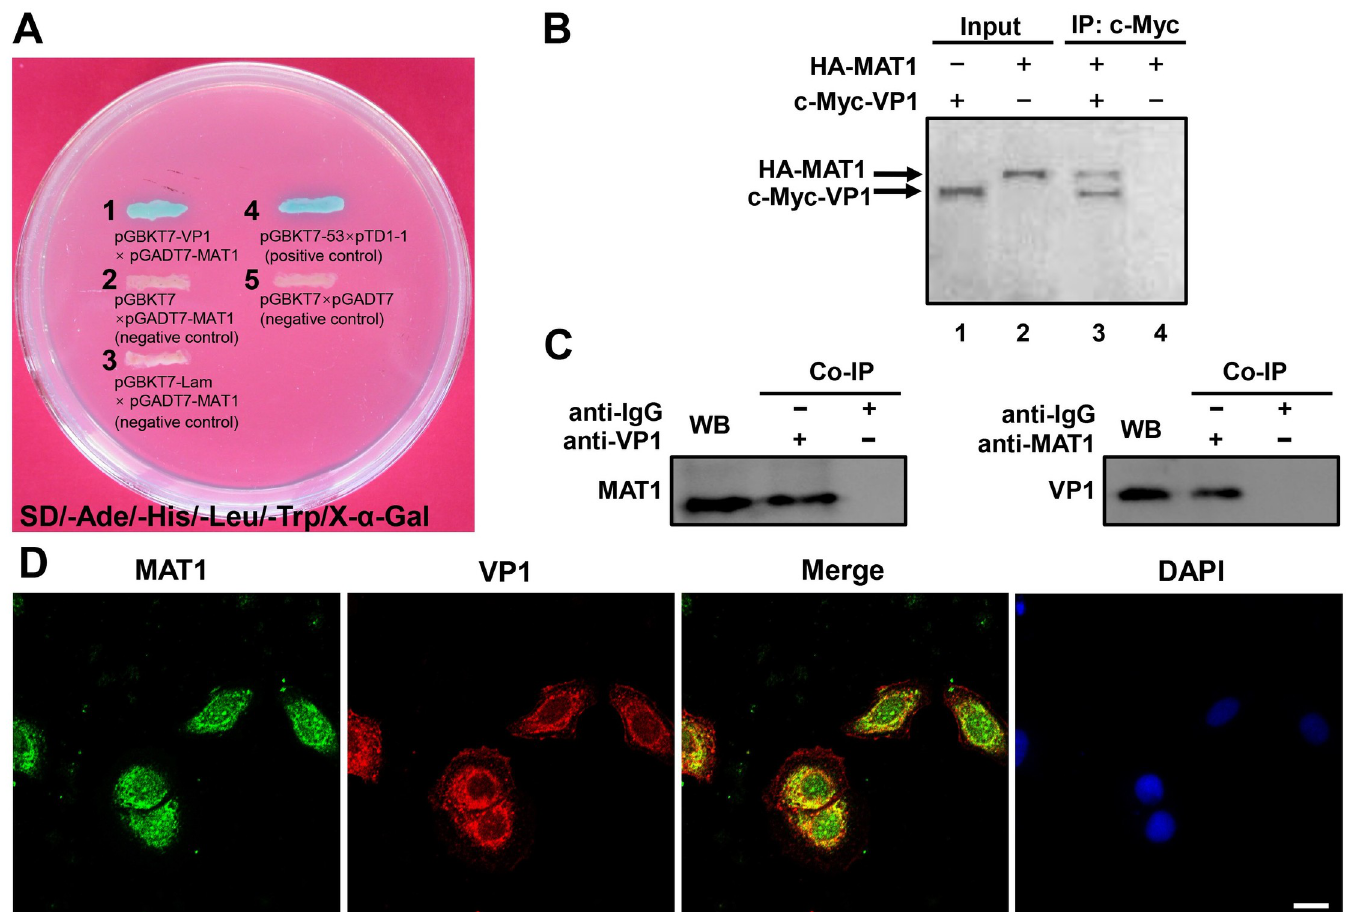
Fig 2. CVB3 VP1 may directly interact with MAT1. (A) Plasmids pGBKT7-VP1 and pGADT7-MAT1 were co-transformed with yeast strain AH109, and the positive result selected on high-stringency medium (SD/-Ade/-His/-Leu/-Trp/X- α -Gal). Interaction is reflected by blue color, while white colonies suggest no interaction. (B) the VP1-MAT1 interaction identified by transcription-translation system in vitro . Plasmids HA-MAT1 and c-Myc-VP1 were labeled with 35 S-Methionine, and immunoprecipitated with antibody against c-Myc; the binding proteins with 35 S-Methionine were analyzed by 10% SDS-PAGE and autoradiography. (C) Co- immunoprecipitation detected the interaction of VP1 and MAT1 in CVB3 infected cells. At 3 hours post infection, the cells lysates of mock and CVB3 infected cells were incubated with or without monoclonal antibody against MAT1 or irrelevant IgG affinity gel, and analyzed by western blotting with the specific antibodies after immunoprecipitation. Original blots are shown in S16 Fig for statistical analysis. (D) MAT1 and VP1 intracellular localization in CVB3 infected HPAC cells. Representative confocal immunofluorescence microscopic images of MAT1 and VP1 stained with rabbit anti-MAT1 (green) and mouse anti-VP1 antibodies (red), respectively, the MAT1 and VP1 images were also merged; the nuclei are labeled with DAPI. Scale bar = 10 μ m. Values are shown as the mean ± SEM of three independent experiments. ( � P < 0.05, �� P <